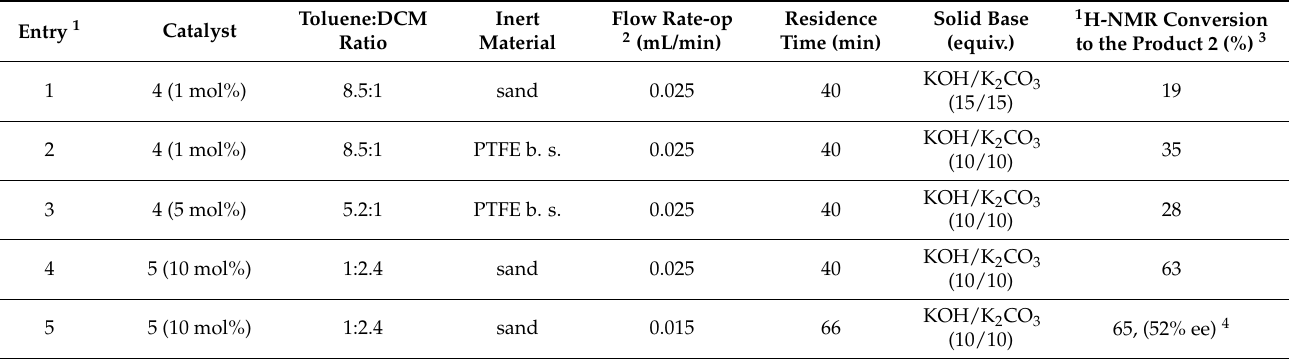
Table 3. Solid-liquid asymmetric phase transfer benzylation of L-alanine imine 1 in packed-bed reactor-reaction mixture delivered by syringe pump (Figure 3a).